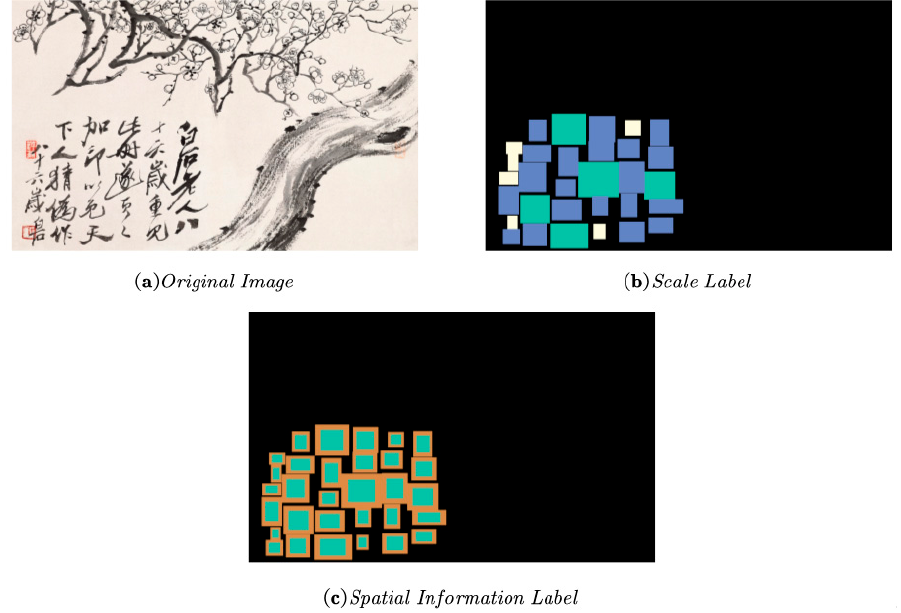
Figure 9. Schematic diagram of training label generation. The meaning of color is the same as that in Figure 5.